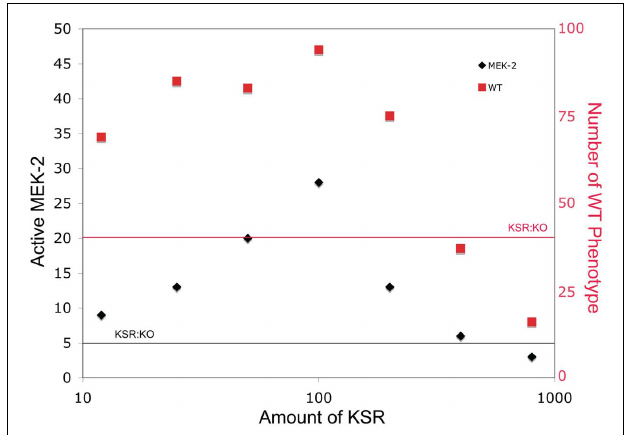
FIGURE 4 |The amplification of signal by transcription and translation. The signal activates transcriptional regulator LIN-31, leading to expression of LIN-39.This in turn leads to creation of LAG-2, which initiates lateral signaling to neighboring cells. Here the (A) mRNA levels and (B) protein levels in P6.p averaged over 100 organisms are